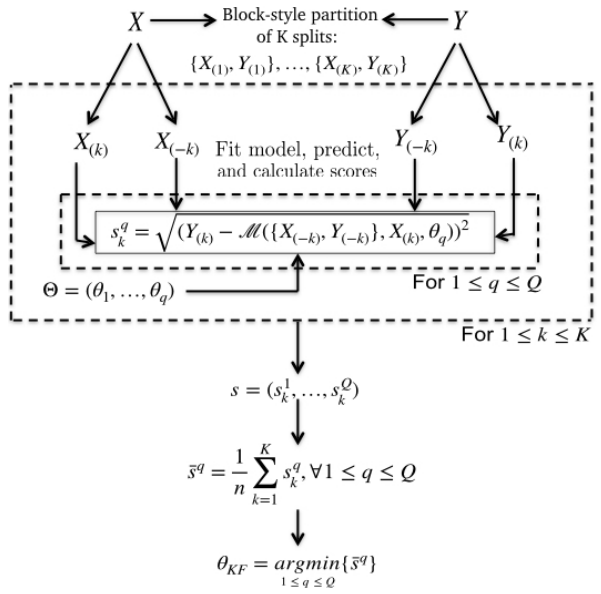
Figure 3. Scheme of a K -fold cross-validation procedure to select the optimal control parameter of a specific learning method M . X is the input set of predictors and Y the corresponding variability mode index. ∀ 1 ≤ i ≤ n , { X (k) , Y (k) } is the k th block-style-based group of observation and { X ( − k) , Y ( − k) } contains all observations except the i th. (cid:50) = (cid:0) θ 1 ,..., θ Q (cid:1) is the ensemble of possible values of the s control parameters θ ∈ R s